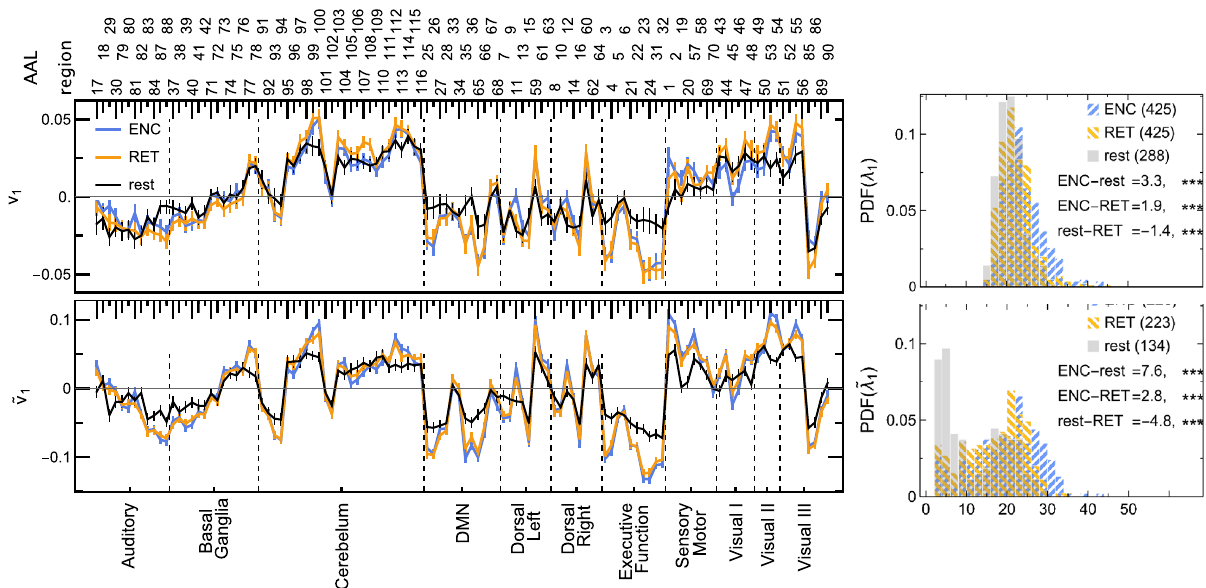
Figure 7. Average elements of (top left) the principal eigenvector and (bottom left) the first aligned eigenvector of ρ correlation matrices for encoding, retrieval, and resting state. The bars mark standard errors over all subjects, tasks, and conditions. Histograms of eigenvalues of (top right) the principal eigenvector and (bottom right) the first aligned eigenvector of nonlinear correlation matrices for encoding, retrieval and resting state pooled over all subjects, tasks and conditions. The values below the legend indicate the location differences between pairs of distributions. Experimental phases ( ENC encoding, RET retrieval), resting-state